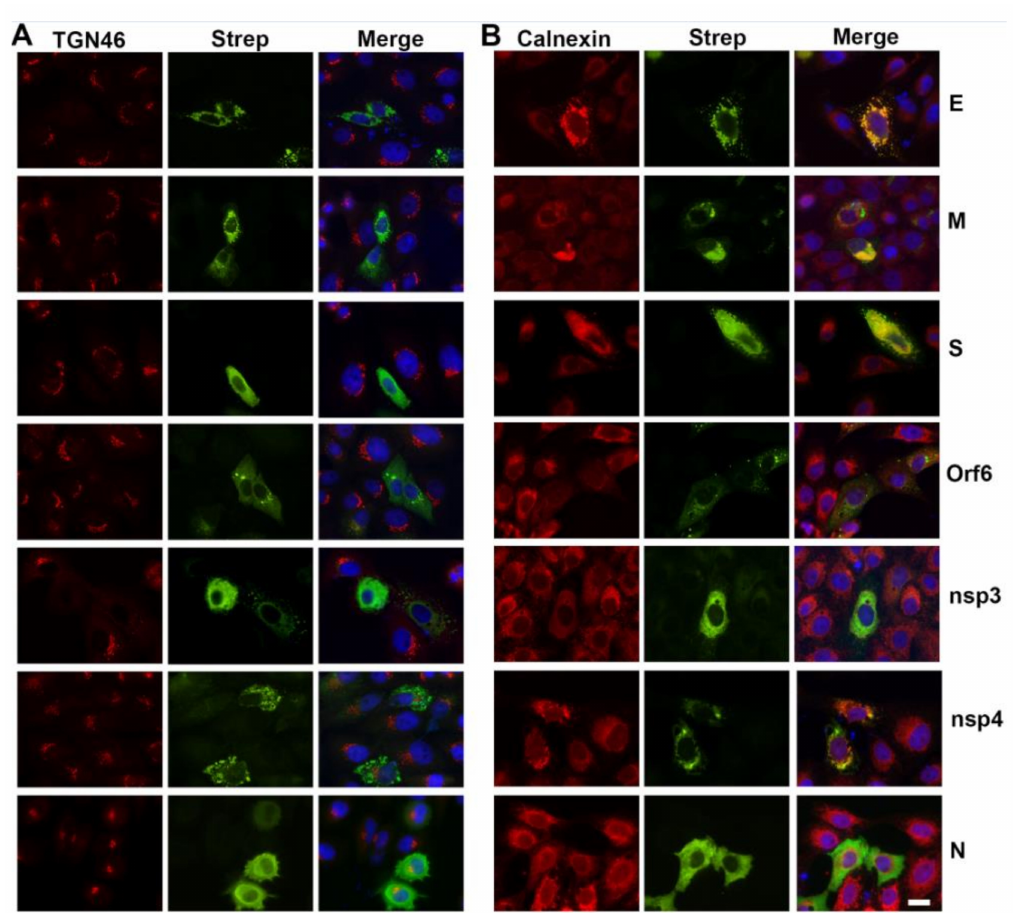
Figure 9. Effects of individual SARS-CoV-2 protein expression on cellular organization in transfected cells. Results are shown from Vero E6 cells transfected with epitope (Strep)-tagged E, M, S, Orf6, nsp3, nsp4, or N proteins (green). Golgi and ER architecture were monitored by labeling with anti-TGN46 ( A ) or anti-calnexin ( B ), respectively (red). Merged images are counterstained with DAPI (blue). Note the fragmentation of the Golgi apparatus by E, M, S, Orf6, or nsp3 expression. Note also changes in ER structure by all except the N protein. Bar = 10 µ